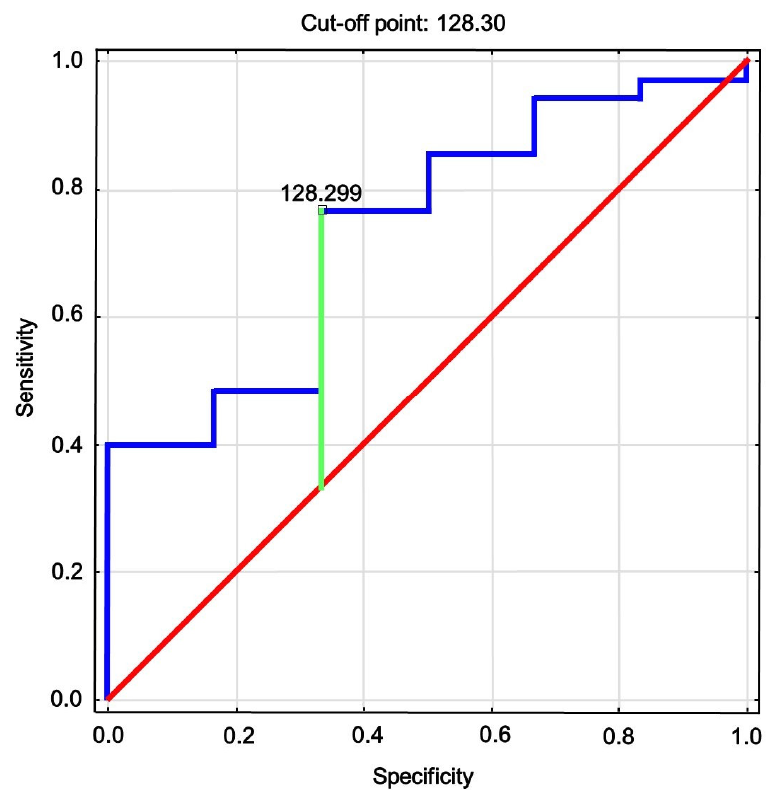
Figure 1. Receiver operating characteristics of bone Zn/Cu ratio for identifying total body BMD >−1 SD.